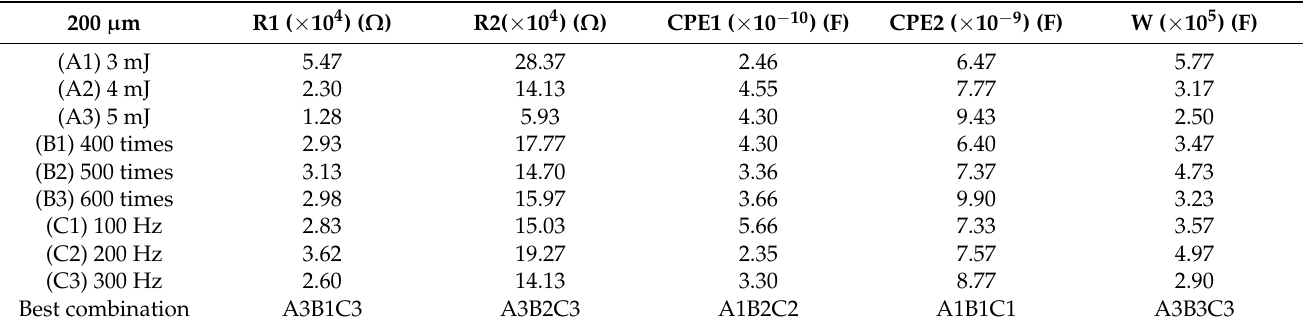
Table 12. Mean analysis data for 200-diameter circular template from the key components of equiva- lent circuit